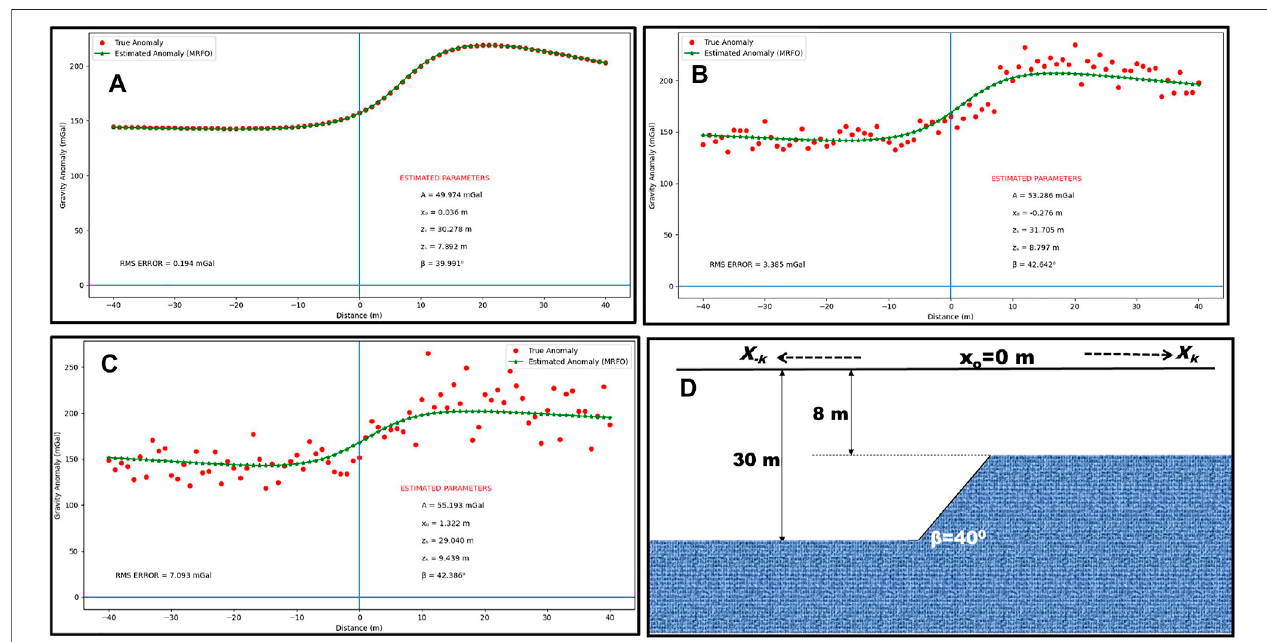
FIGURE 4 | Actual and estimated anomalies (gravity) of a synthetic dipping fault structure with (A) 0% (B) 5% (C) 10% Gaussian noise using MRFO algorithm (D) Sketch of the fault model.